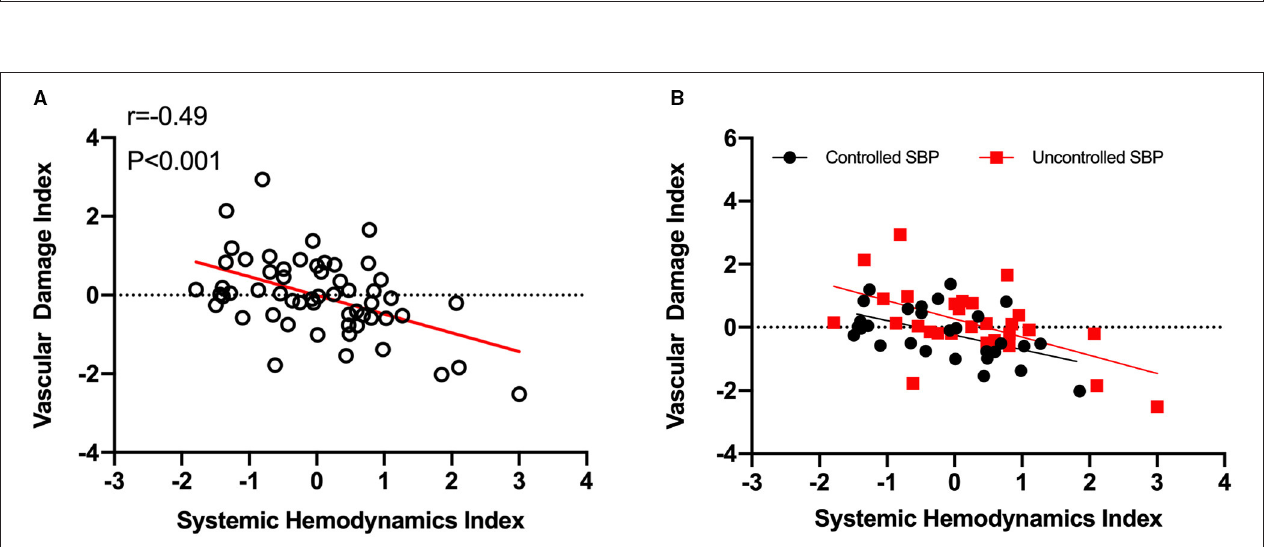
FIGURE 4 | Hypertensive vascular impairment is associated with systemic hemodynamics index decline. (A) , Systemic hemodynamics index decrease predicts vascular impairment in hypertensives. The systemic hemodynamics index showed a significantly negative correlation with vascular damage index ( r = − 0.49, p < 0.001). (B) , Similar tendencies were discovered in both controlled ( n = 29, r = − 0.52, p < 0.01) and uncontrolled SBP ( n = 28, r = − 0.56, p < 0.01). SHI, systemic hemodynamics index; VDI, vascular damage index; SBP, systolic blood